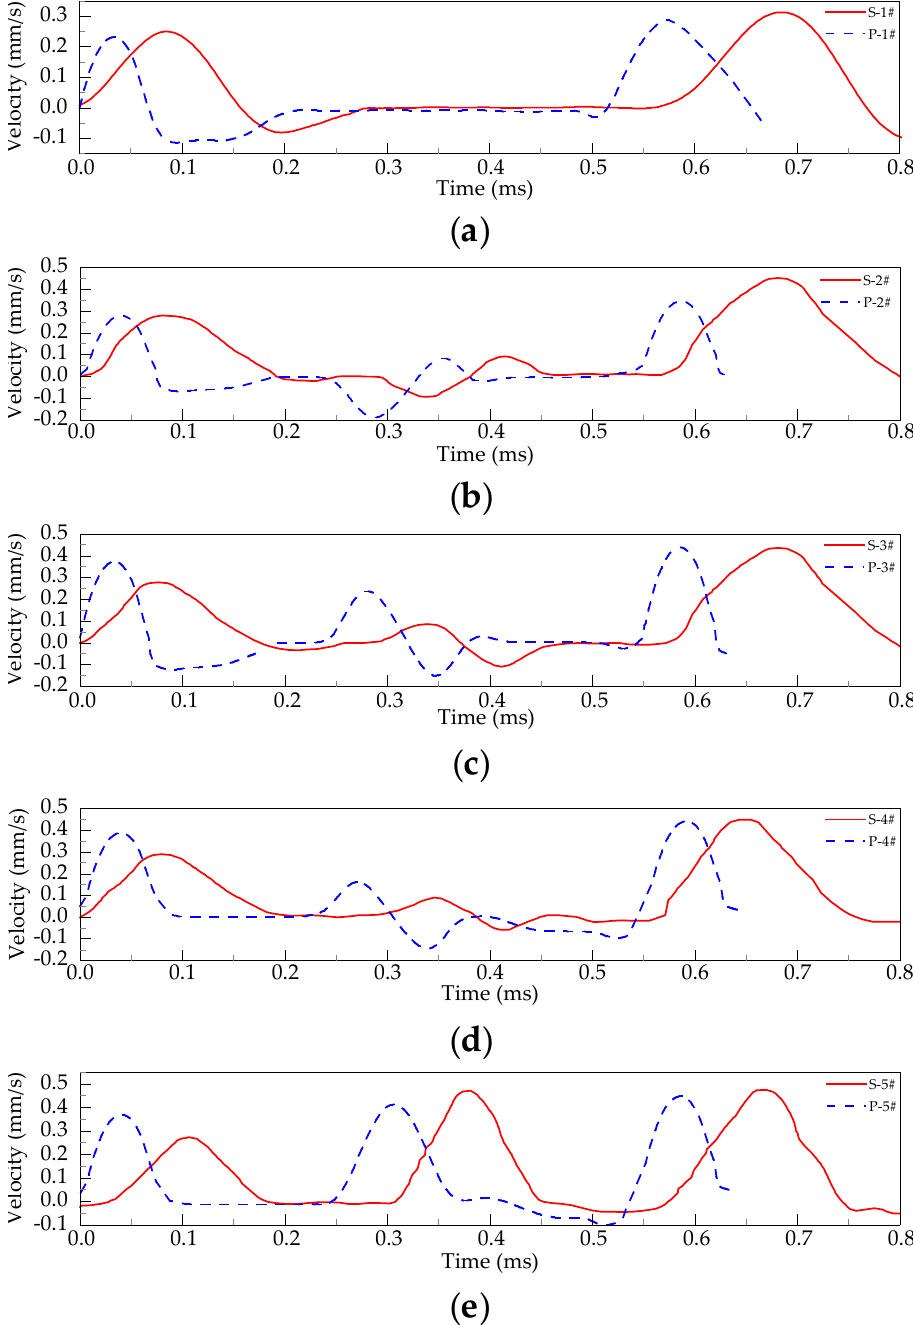
Figure 9. Comparison of finite element simulation results and experimental results: ( a ) 1# model pile; ( b ) 2# model pile; ( c ) 3# model pile; ( d ) 4# model pile; ( e ) 5# model pile. Table 5. Comparison table between finite element simulation results and experimental results.